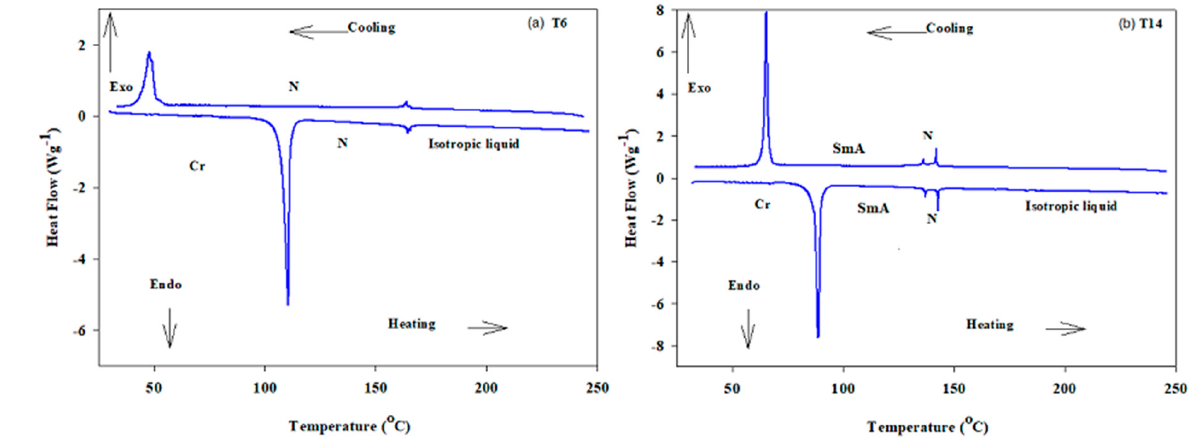
Figure 1. DSC thermograms of ( a ) T6 and ( b ) T14 samples.